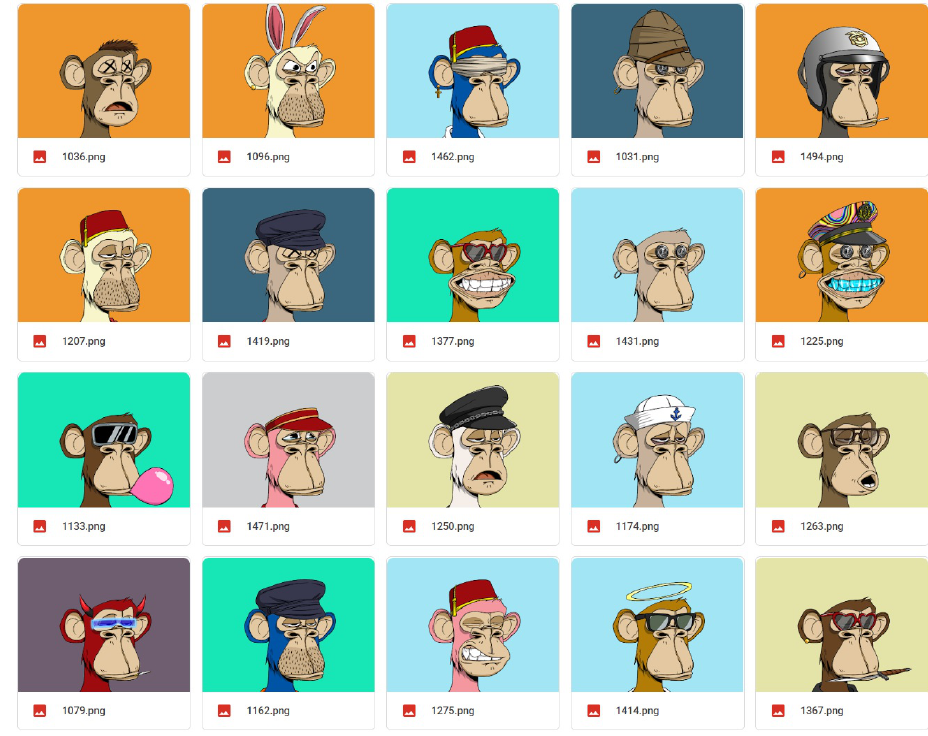
Figure 2. Sample images of NFT dataset